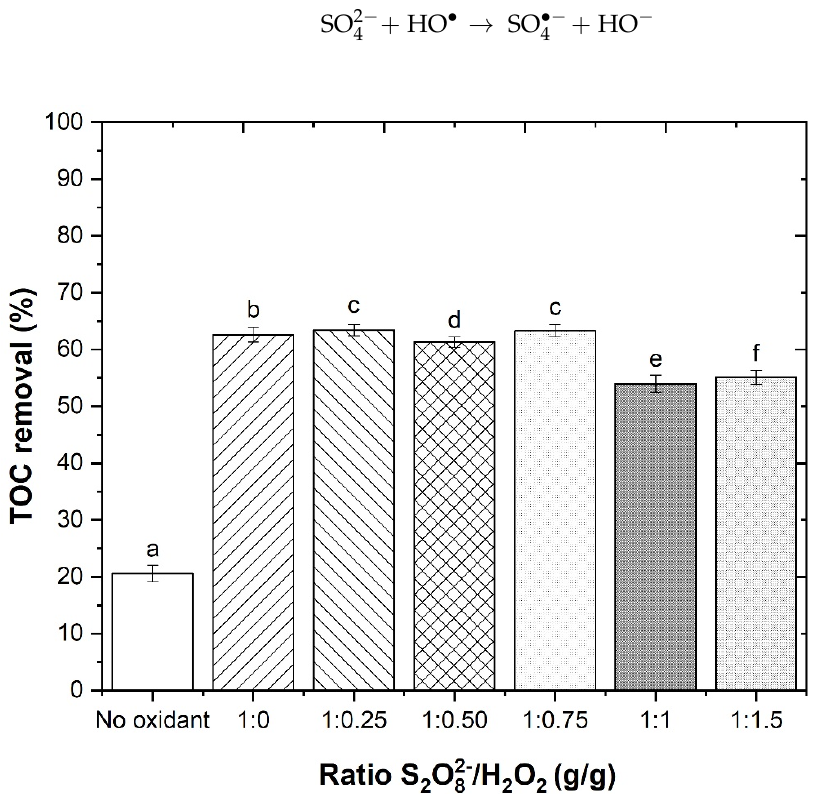
Figure 5. Evolution of TOC removal throughout different S 2 O 82 - /H 2 O 2 ratio (1:0–1:1.5) in thermocatalytic oxidation, under the following operational conditions: [S 2 O 8 2 - ] = 1.0 g/L, pH = 11.0, T = 333 K, agitation 350 rpm, t = 2 h. A blank experiment under the following operational conditions is also shown as reference: pH = 11.0, T = 333 K, agitation 350 rpm, t = 2 h. Means in bars with different letters represent significant differences ( p < 0.05) between each ratio.